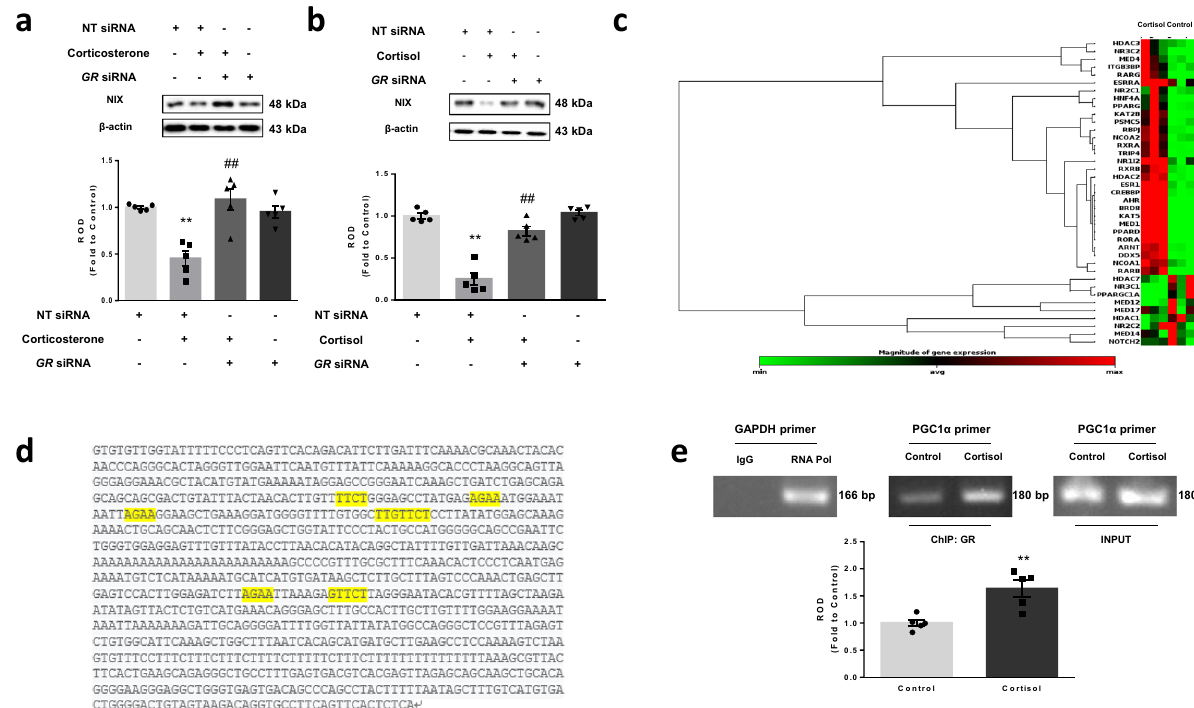
Fig. 6 GR-dependent downregulation of NIX expression via PGC1 α . a , b Nontargeting (NT) or GR siRNA was transfected to hippocampal neurons and SH-SY5Y cells for 24 h prior to corticosterone and cortisol for 24 h, respectively. NIX expression was detected in western blot where β -actin was used as a loading control. n = 5. c SH-SY5Y cells were incubated with cortisol for 6 h. The mRNA expression levels of genes associated with nuclear receptors and coregulators were assessed by RT2 Pro fi ler PCR array. Heat maps with hierarchical clustering were acquired by using the GeneGlobe Data analysis Center on Qiagen website. n = 3. d A thousand base pair upstream of the fi rst codon of the PPARGC1A was described and the putative GRE binding sequence was emphasized with yellow labeling. e SH-SY5Y cells were incubated with cortisol for 6 h. DNA was immunoprecipitated with IgG, RNA polymerase (RNAPol), and glucocorticoid receptor (GR) antibody. The immunoprecipitation and input samples were ampli fi ed with primers of GAPDH and PPARGC1A gene. n = 5. All blots are representative. n = 3 or 5 from independent experiments with two technical replicates each, respectively. Quantitative data are presented as a mean ± S.E.M. Two-sided two-way ANOVA was conducted in Fig. 6a, b. Two-sided unpaired student ’ s t test was conducted in Fig. 6e. ** indicates p < 0.01 versus control. ## indicates p < 0.01 versus corticosterone in hippocampal neurons and cortisol in SH-SY5Y, respectively. Data are provided as a Source data fi